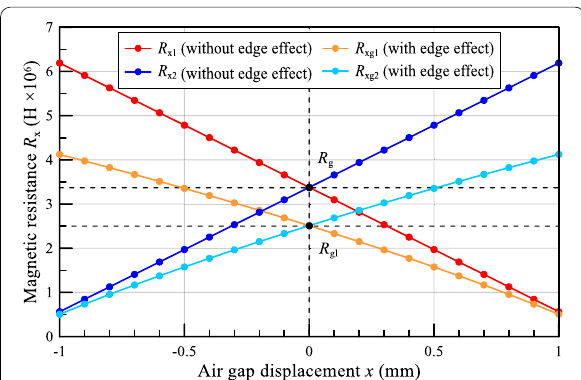
Figure 9 Variation of air gap reluctance with air gap displacement x